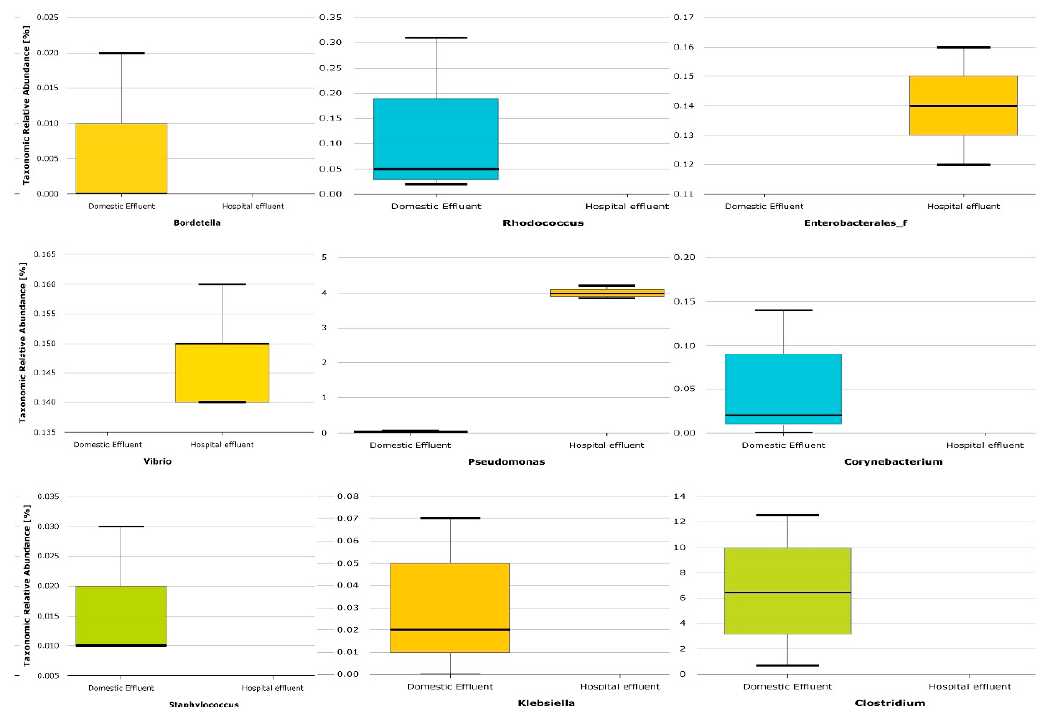
Figure 4. Box plots representing the relative abundance (%) of pathogenic bacterial members in collected wastewater samples. Median values (horizontal line) and interquartile ranges have been depicted in the plots.